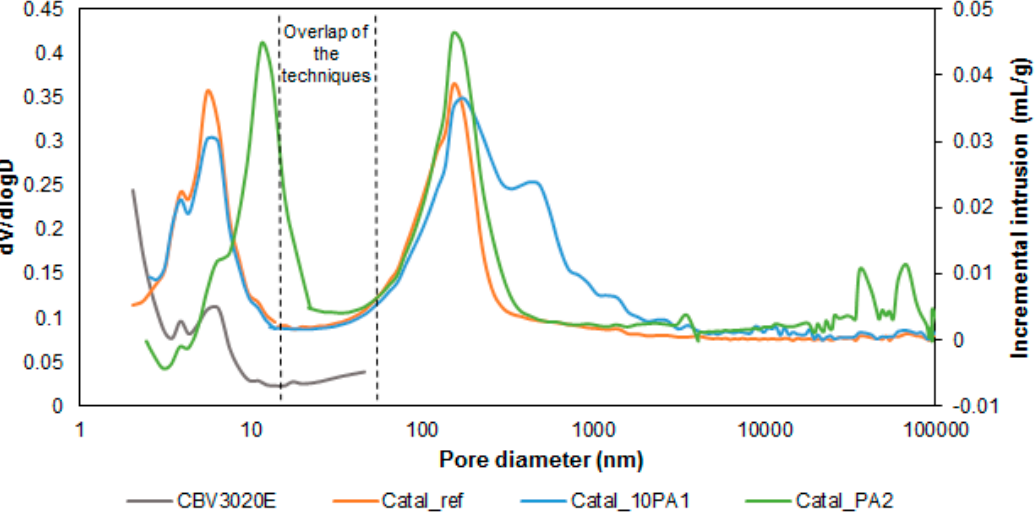
Figure 1. Pore size distribution profiles of the samples obtained by N 2 adsorption isotherms (from 1 to 50 nm) and mercury intrusion porosimetry (MIP, from 20 to 100,000 nm).